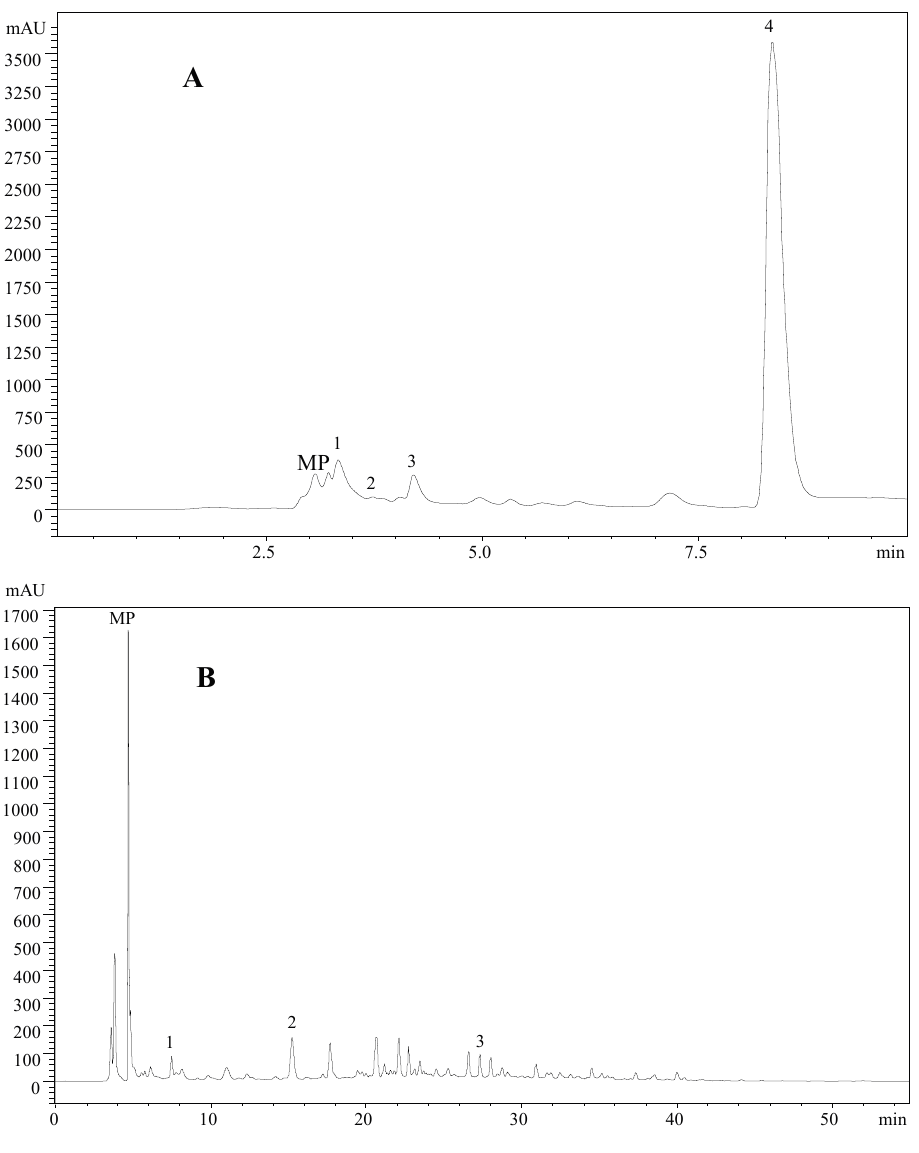
Figure 2. Individual profile in organic acids ( A ) of L. citriolens : 1-oxalic acid, 2-quinic acid, 3-malic acid, 4-fumaric acid; and phenolic acids ( B ) of L. turpis : 1-gallic